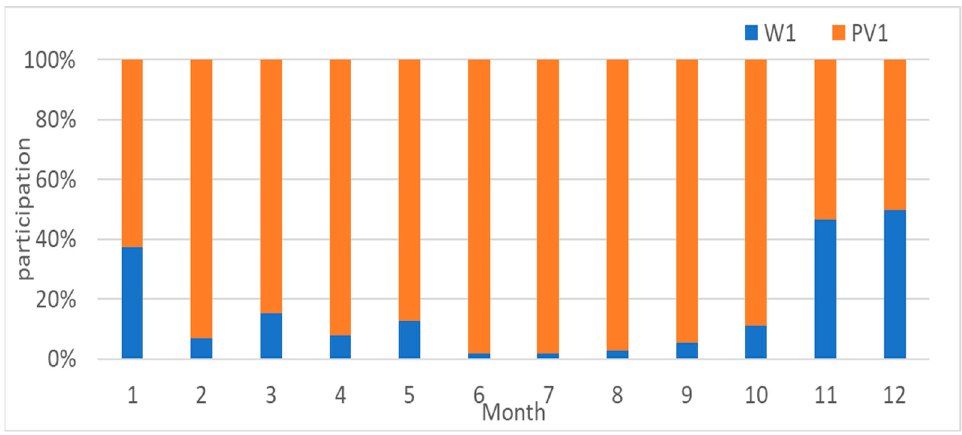
Figure 20. Monthly energy generation by PV1 and W1 sections in 2021 (own measurement data).